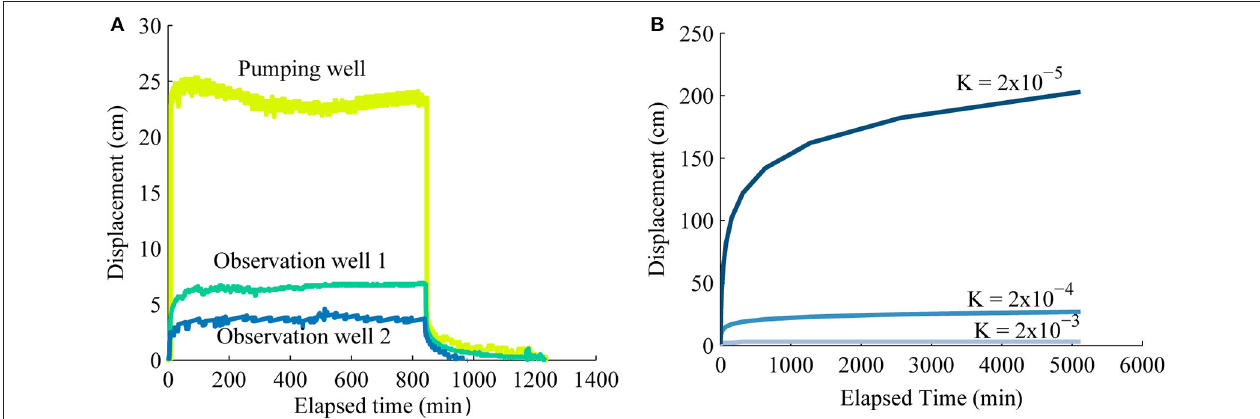
FIGURE 7 | Observed and theoretical drawdown. Displacement over time at site FA16_6 in the pumping and observation wells during the first test (A) and predicted drawdown in an observation well for a hypothetical aquifer test with varying hydraulic conductivity (B) . For this scenario, the aquifer is 15m thick, the pumping rate is 0.0011 m 3 /s, the storativity is 0.2, and the distance between the pumping and observation well is 1 m. The predicted drawdown when hydraulic conductivity is 2 × 10 − 4 m/s is most similar to the drawdown we